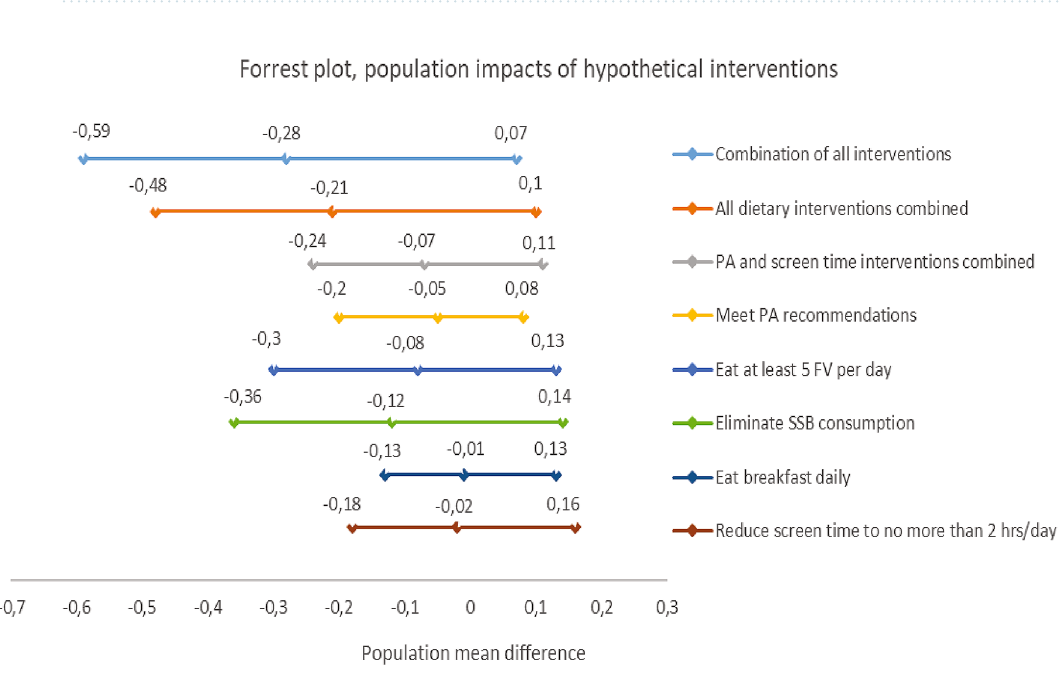
Table 1. Baseline and follow-up characteristics of participants (n = 530). BMI body mass index, PA physical activity, SSB sugar-sweetened beverages.